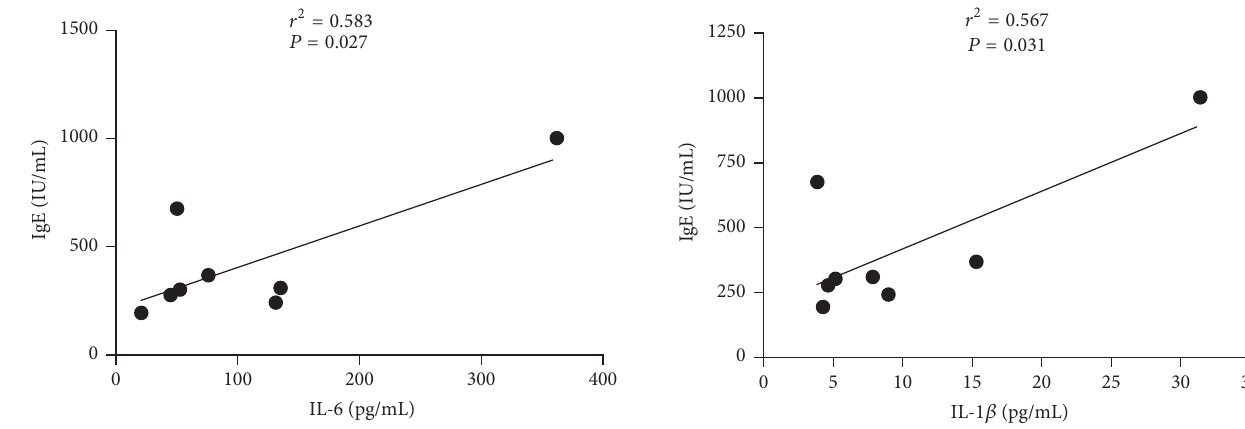
Figure 4: Association between IL-1 𝛽 and IgE for RF+IgE+ SLE